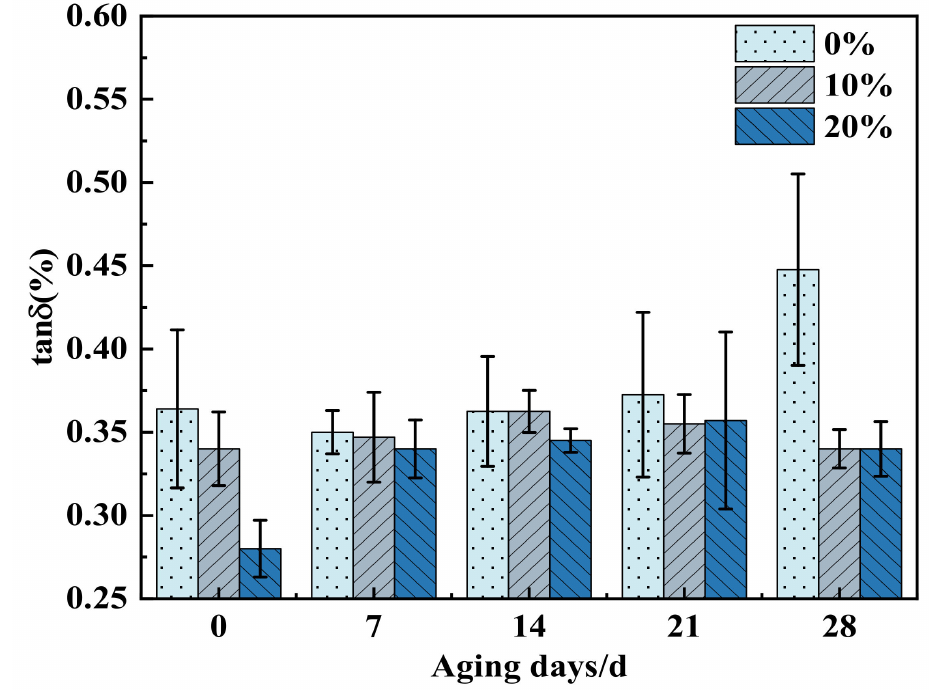
Figure 2. Dielectric loss tangent of cycloaliphatic blend resins with different proportions during salt